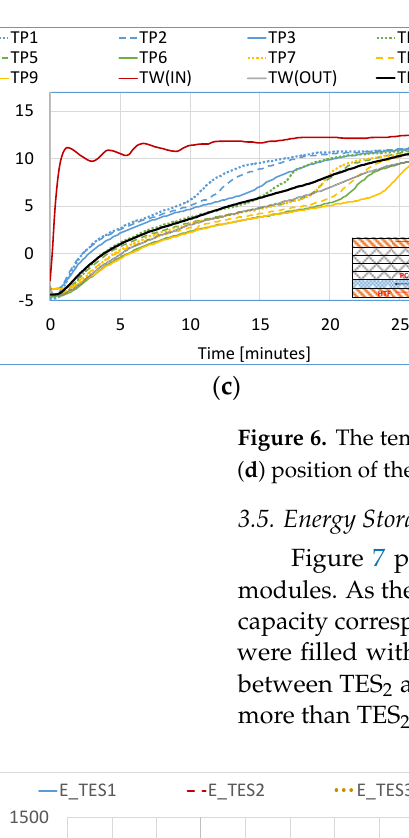
ence between TES (cid:2870) and TES (cid:2871) is attributed to the sensible material, since TES (cid:2871) weighs